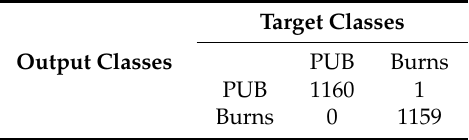
Table 3. SVM classification using ResNet152